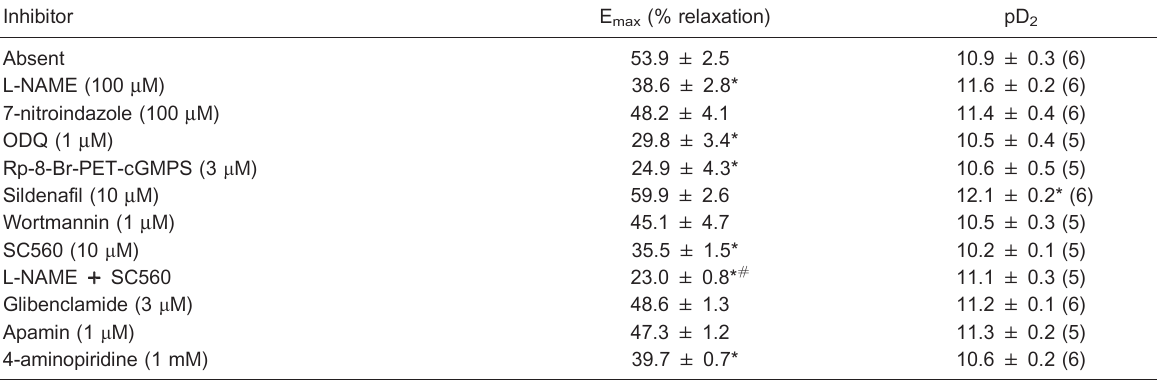
Table 1. Effect of L-NAME, 7-nitroindazole, ODQ (1H-(1,2,4)oxadiazolo[4,3-a]quinoxalin-1-one), wortmannin, Rp-8-Br-PET-cGMPS, sildenafil, and SC560 on the E max and pD 2 values for adrenomedullin in the isolated rat cavernosal smooth muscle. Inhibitor